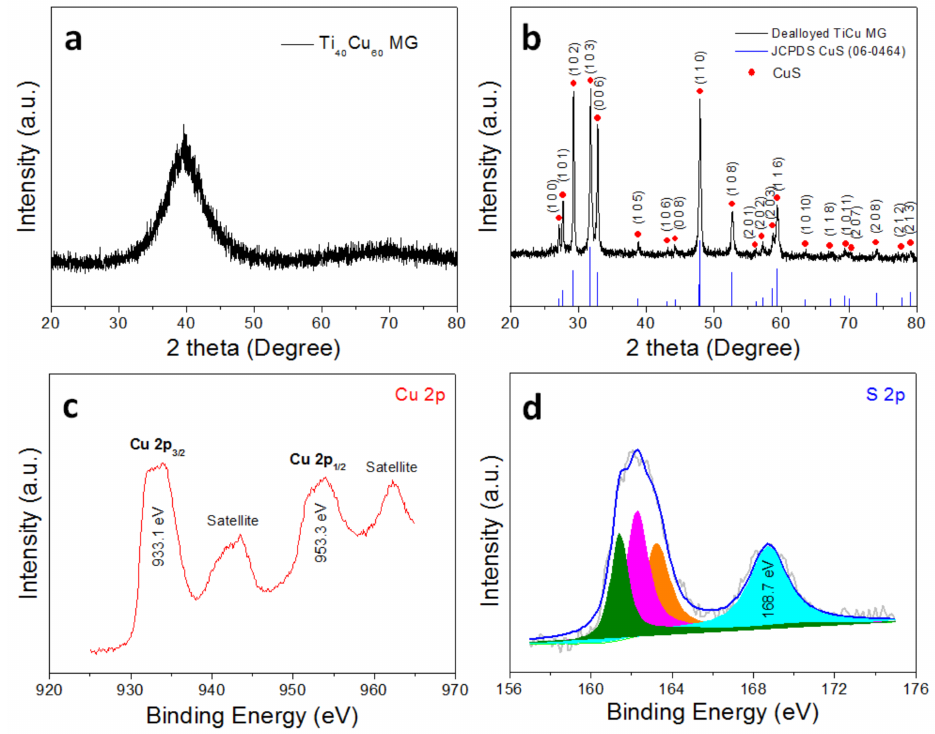
Figure 4. X-ray diffraction (XRD) patterns of the Ti 40 Cu 60 ribbon before ( a ) and after dealloying ( b ). ( c , d ) X-ray photoelectron spectroscopy (XPS) spectrums of the as-obtained CuS: ( c ) Cu 2p, ( d ) S